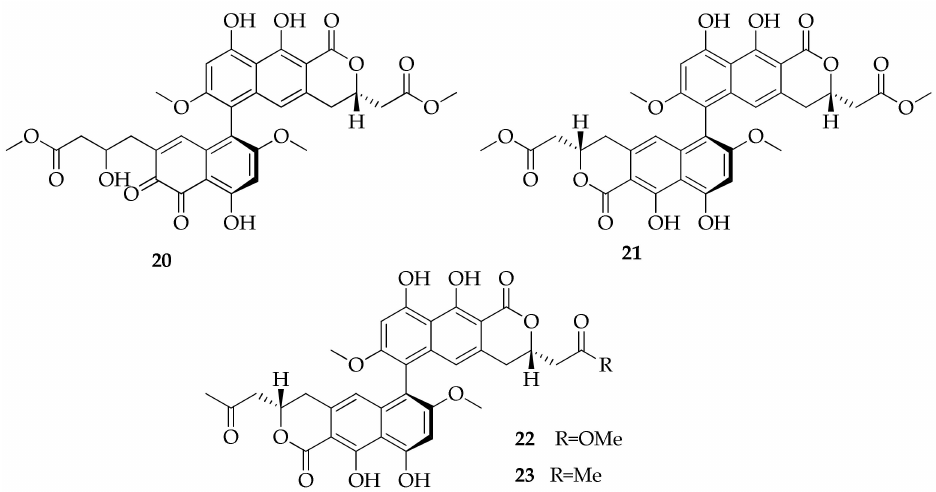
Figure 6. Structures of